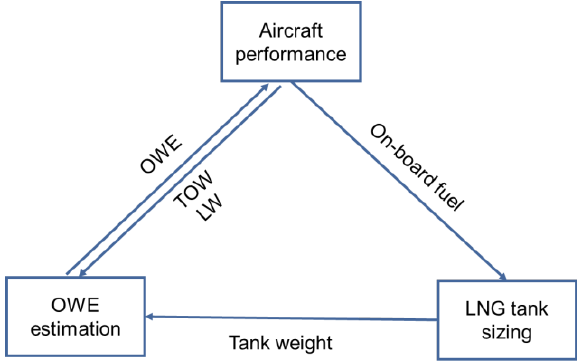
Figure 6. Design mission sizing loop.